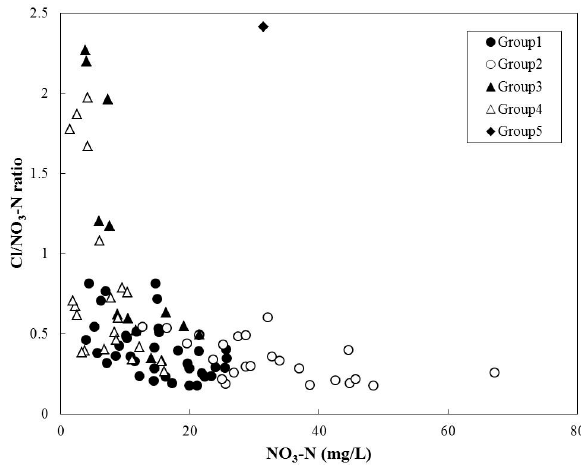
Figure 9. Cl/NO 3 versus NO 3 –N plots of the samples in each clustered groups.